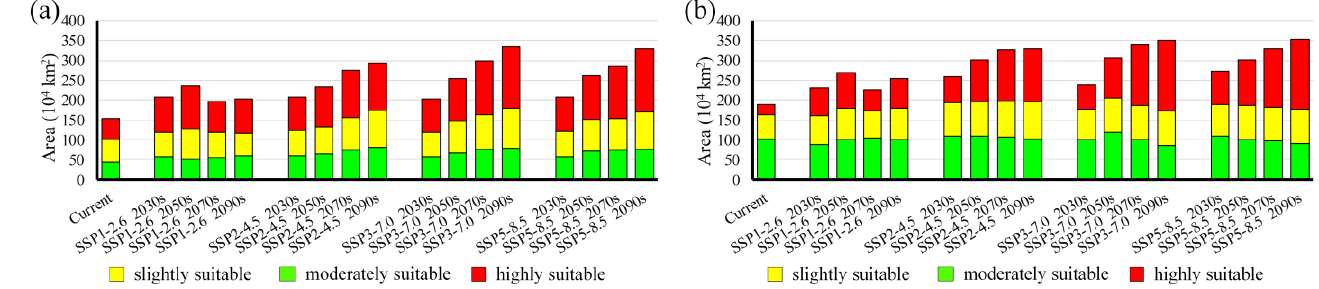
Figure 4. Comparison of potential suitable areas for ( a ) MEAM1 and ( b ) MED cryptic species of the Bemisia tabaci species complex in China under current and future climate scenarios. SSP, shared socioeconomic pathway.